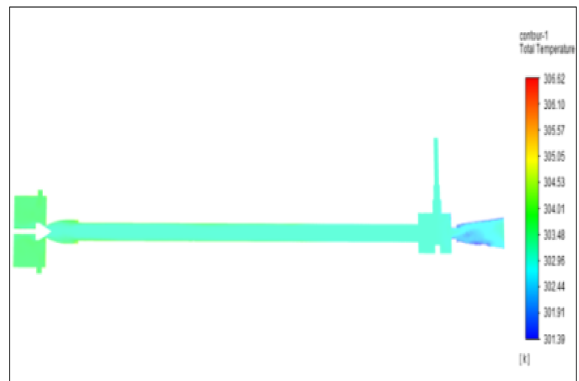
Figure 15. Acrylic at 4 bar.